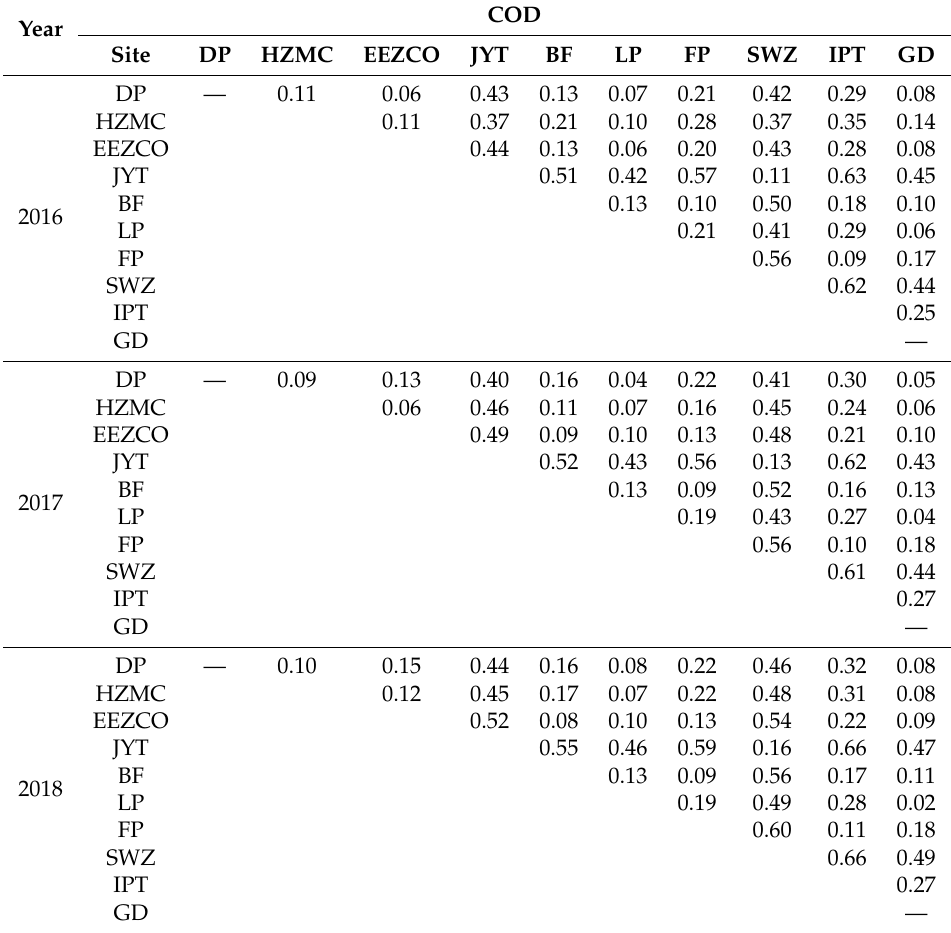
Table 1. Coe ffi cients of divergence for NO x obtained at the 10 monitoring sites in 2016–2018.